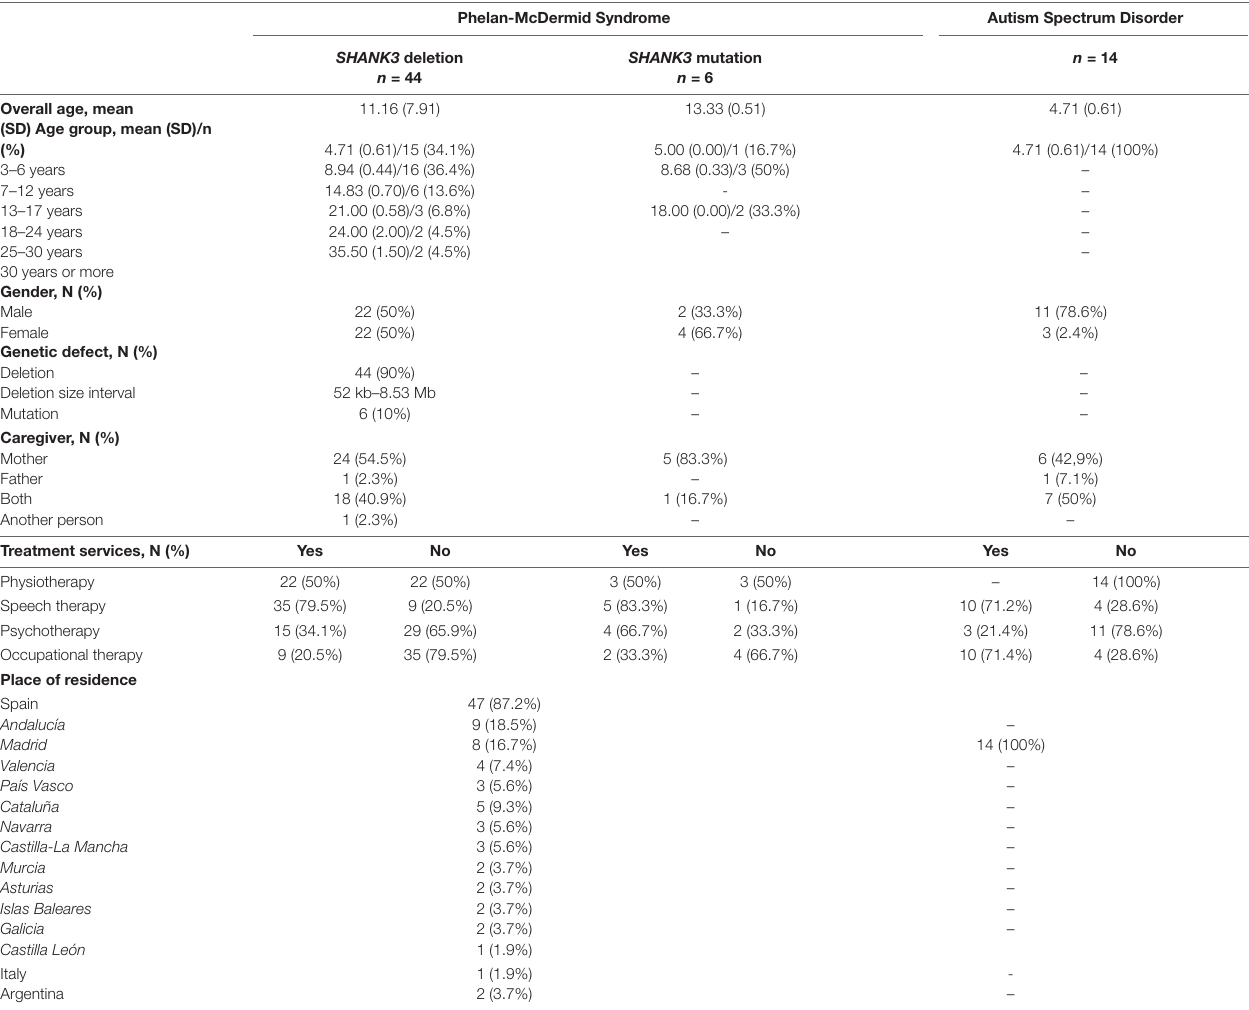
TABLE 1 | Participants demographic data.